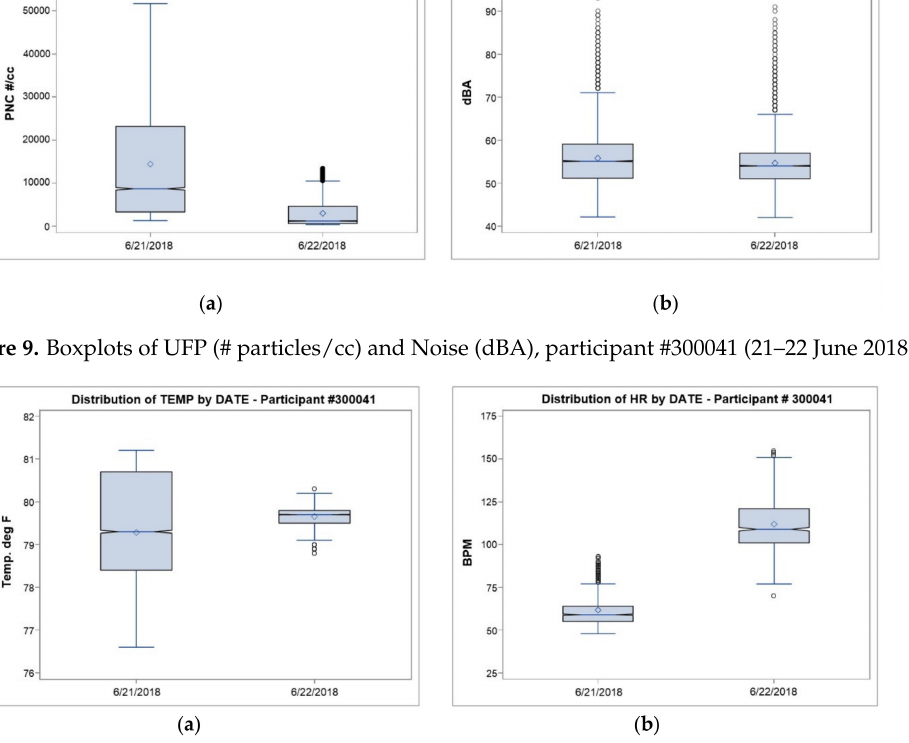
Figure 10. Boxplots of Temp. ( o F) and Heart-Rate (BPM), participant #300041 (21–22 June